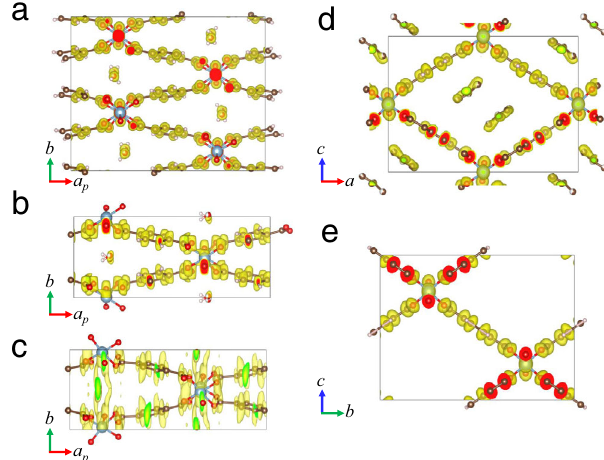
Fig. 4 | Electrostatic potential maps overlaid with crystal structure models obtained from environmental 3D ED data. a MIL-53 lt -cryo, b MIL-53 lt -gas (air), c MIL-53 lt -liquid(H 2 O), d MIL-53 as -vand e MIL-53 as -ht-v.ThestructureofMIL-53 lt - liquid (H 2 O) was solved by the direct-space strategy. Yellow color represents observed potential map while red or green color represent sections between potential map and unit cell boundary. The isosurface level is 2 σ [ V (r)], which is de fi ned in VESTA software as: d (iso)= 〈 | V (r)| 〉 + n × σ (| V (r)|), where 〈 | V (r)| 〉 is the averageof| V (r)| ’ s, σ (| V (r)|)isthestandarddeviationof| V (r)|,and n isaparameterto adjust d (iso). Source data are provided as a Source Data fi